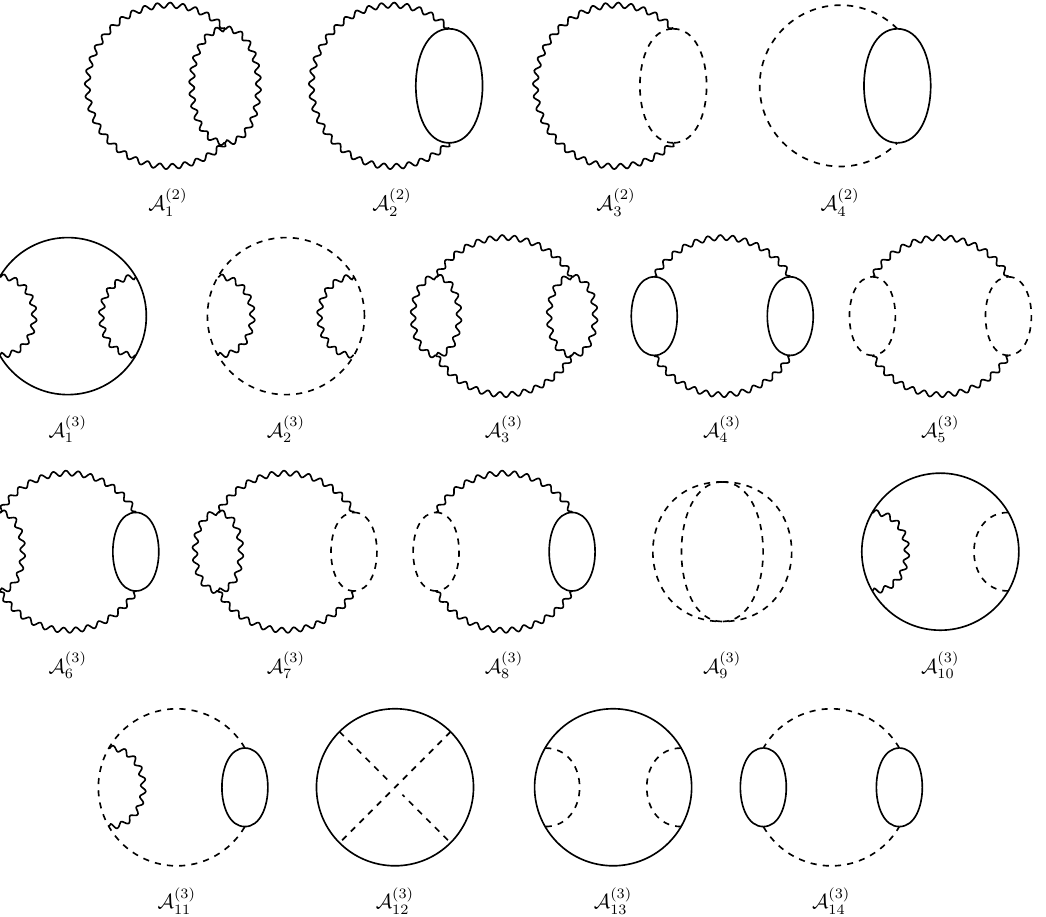
Figure 5 . Graph representation of the 2- and 3-loop contributions to the A -function. Note that (3) the scalar lines in do not intersect. 12 A